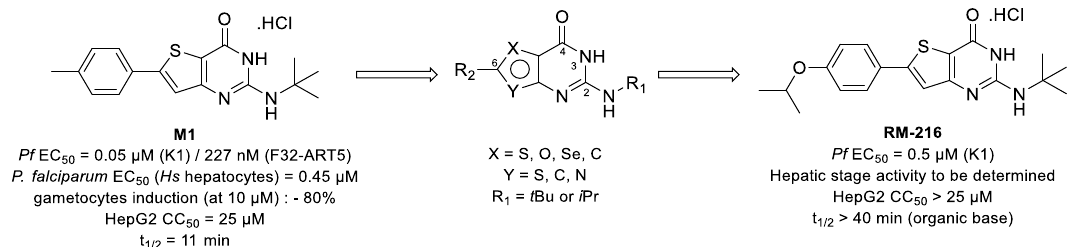
Figure 8. SAR studies conducted on the thieno[3,2- d ]pyrimidine series. 3.4. Benzimidazole Derivatives and Their Analogues as Myeloperoxidase Inhibitors (YRC04)